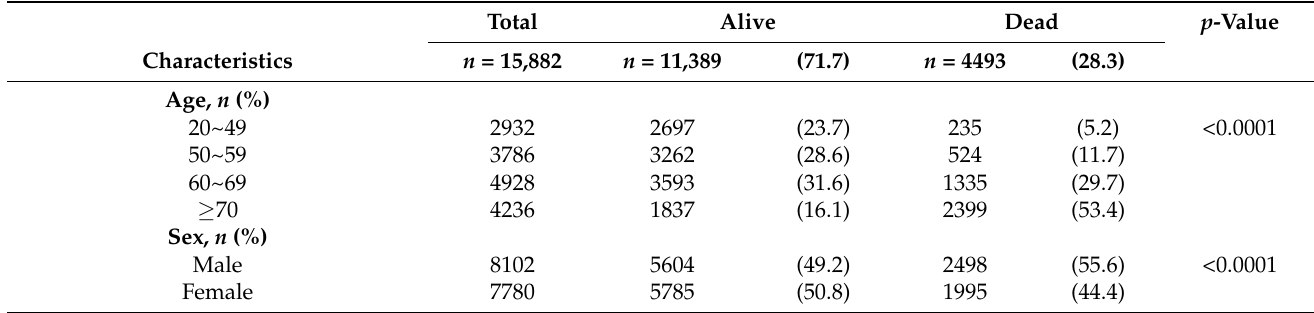
Table 1. Baseline characteristics of newly diagnosed